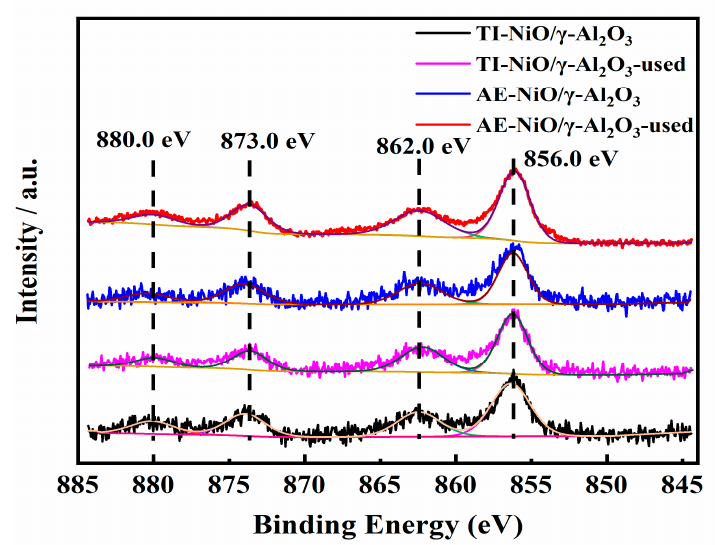
Figure 7. Ni 2p XPS spectra of TI-NOi/ γ -Al 2 O 3 , TI-NiO/ γ -Al 2 O 3 -used and AE-NiO/ γ -Al 2 O 3 , AE-NiO/ γ -Al 2 O 3